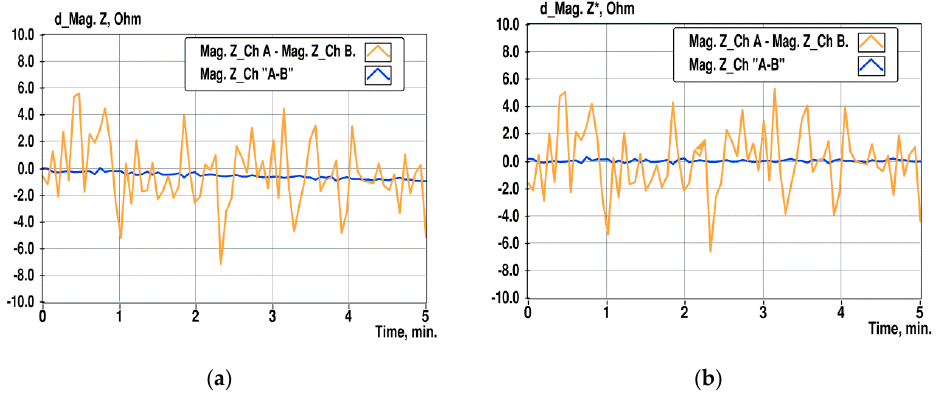
Figure 18. Change of the difference of the impedance magnitudes in channels A and B at 10 kHz, and in the differential channel “A-B” during 5 min of observation ( a ), and linearized differences of the same data ( b ).